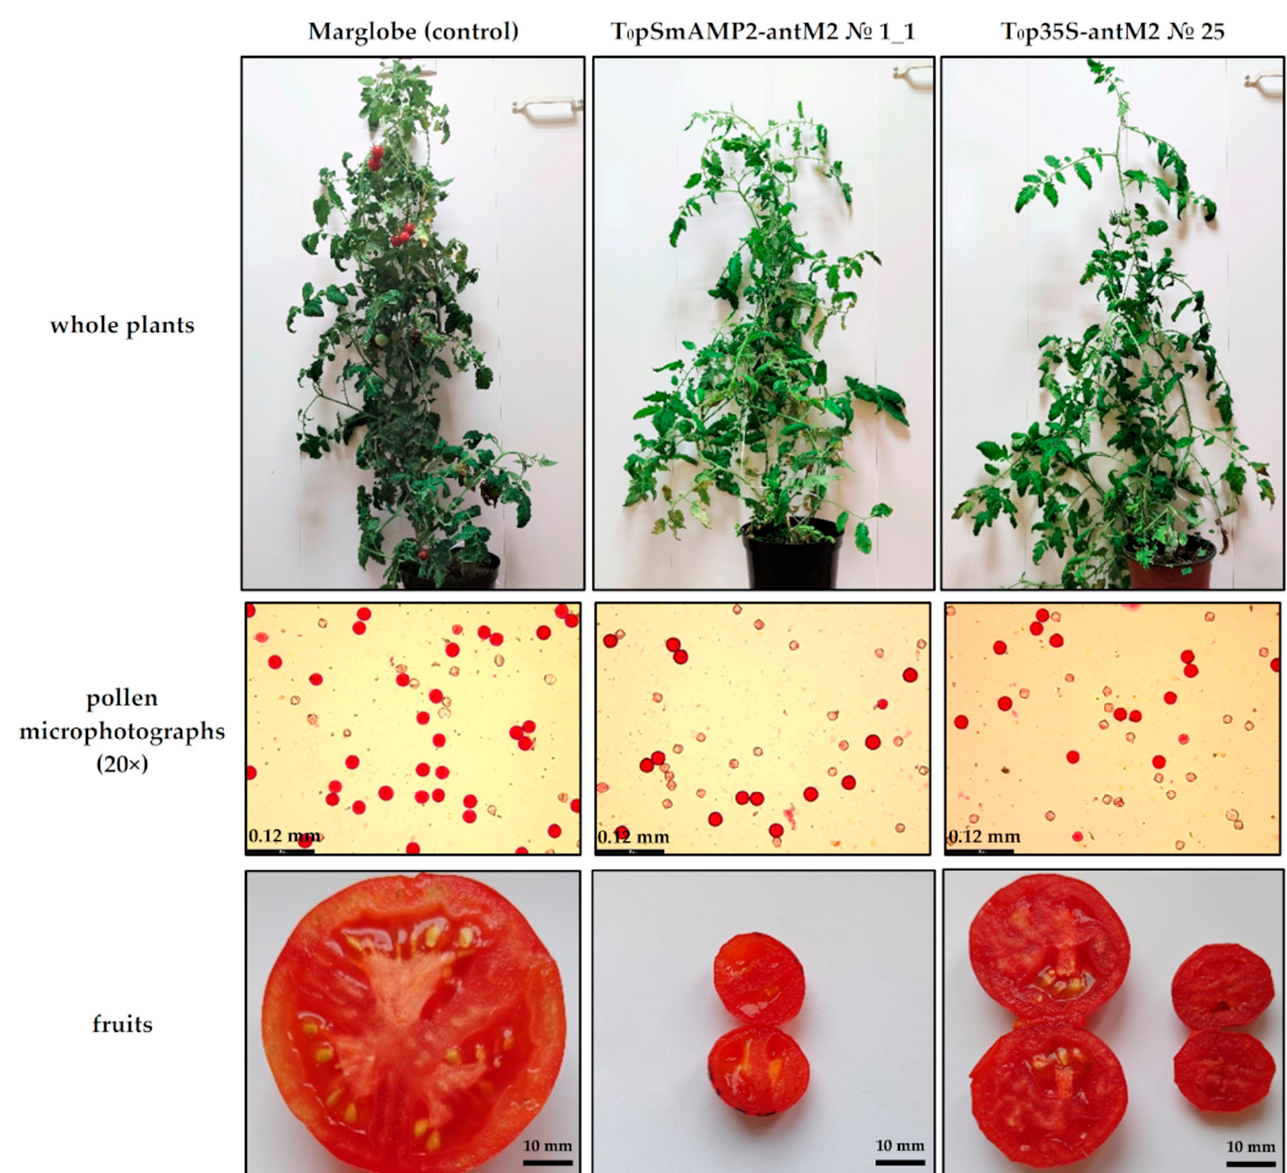
Figure 6. The morphology of several examples of MSH2-RNAi plants under “short-day” (12 h light/12 h dark) condi- tions.